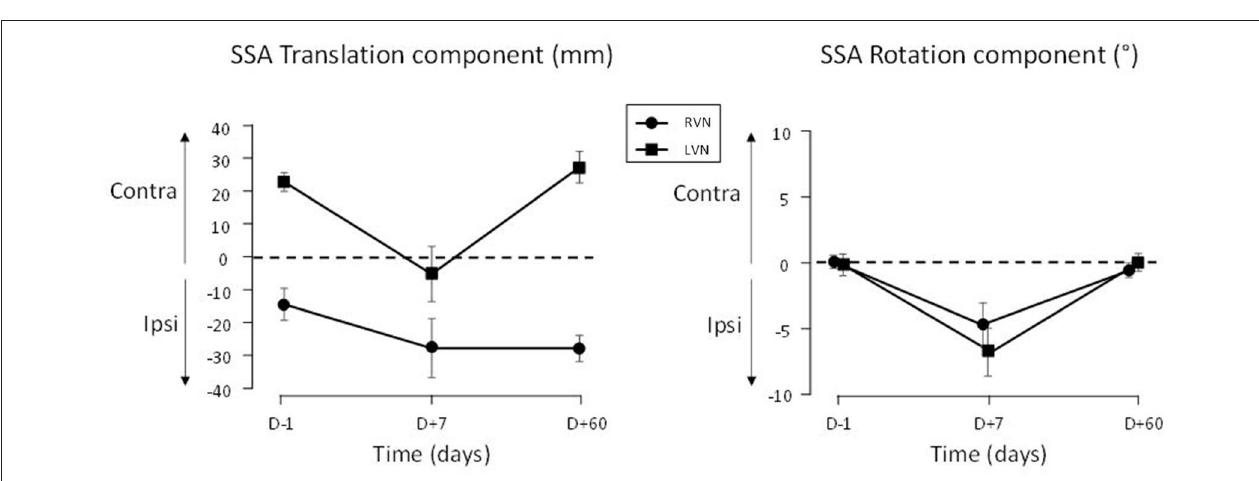
FIGURE 3 | SSA deviation in translation and rotation plotted in ipsi-contra coordinates (relative to the operated side). The SSA is reported for patients with LVN (filled squares) and RVN (filled circles). Positive signs indicate contralateral translation and rotation. The bars show the standard errors.